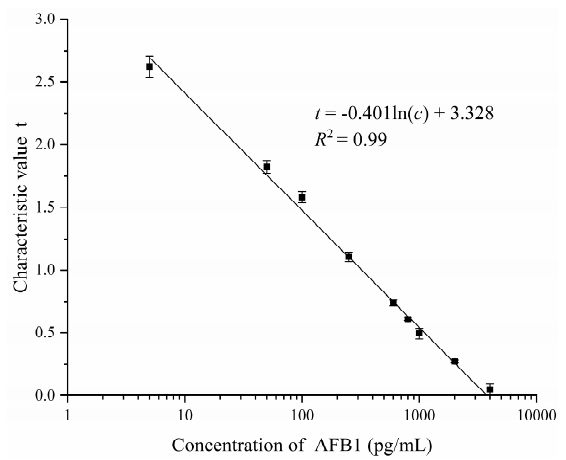
Figure 9. Relationship between the concentration of AFB1 and characteristic value.